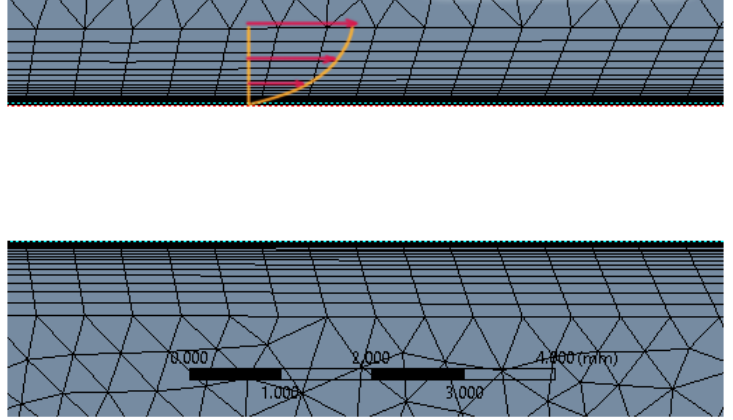
Figure 14. Local capsular discretization to capture the wake distribution of the separated flow. For such dynamic flapping motion, it is possible to implement CFD solver algorithms to mathematically morph the nodes and the grids to support the motion of the flat plate. ANSYS FLUENT supports a variety of mesh motion techniques to aid in transiently morphing the grids in accordance with the varying shape of the flat plate. In this regard, the circular region enclosing the flat plate was modelled as a flapping body with the aid of UDF scripting. Using the in-built CFD C++ code interpreter, the script was compiled and executed to induce flapping motion for the circular region. A prime focus was to at- tain the necessary motion while ensuring quality, efficiency, and robustness. With all